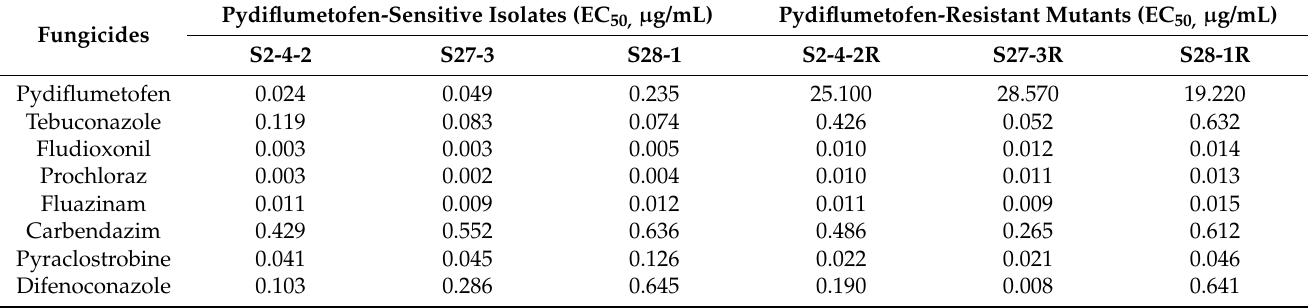
Table 1. Cross-resistance between pydiflumetofen and other commonly used fungicides.